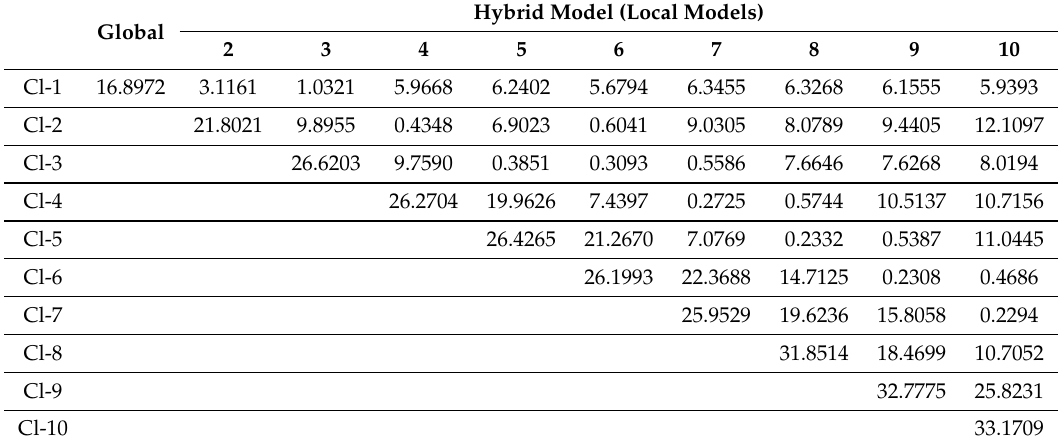
Table 6. Mean squared error (MSE) for each individual hybrid model; all values × 10 − 4 .